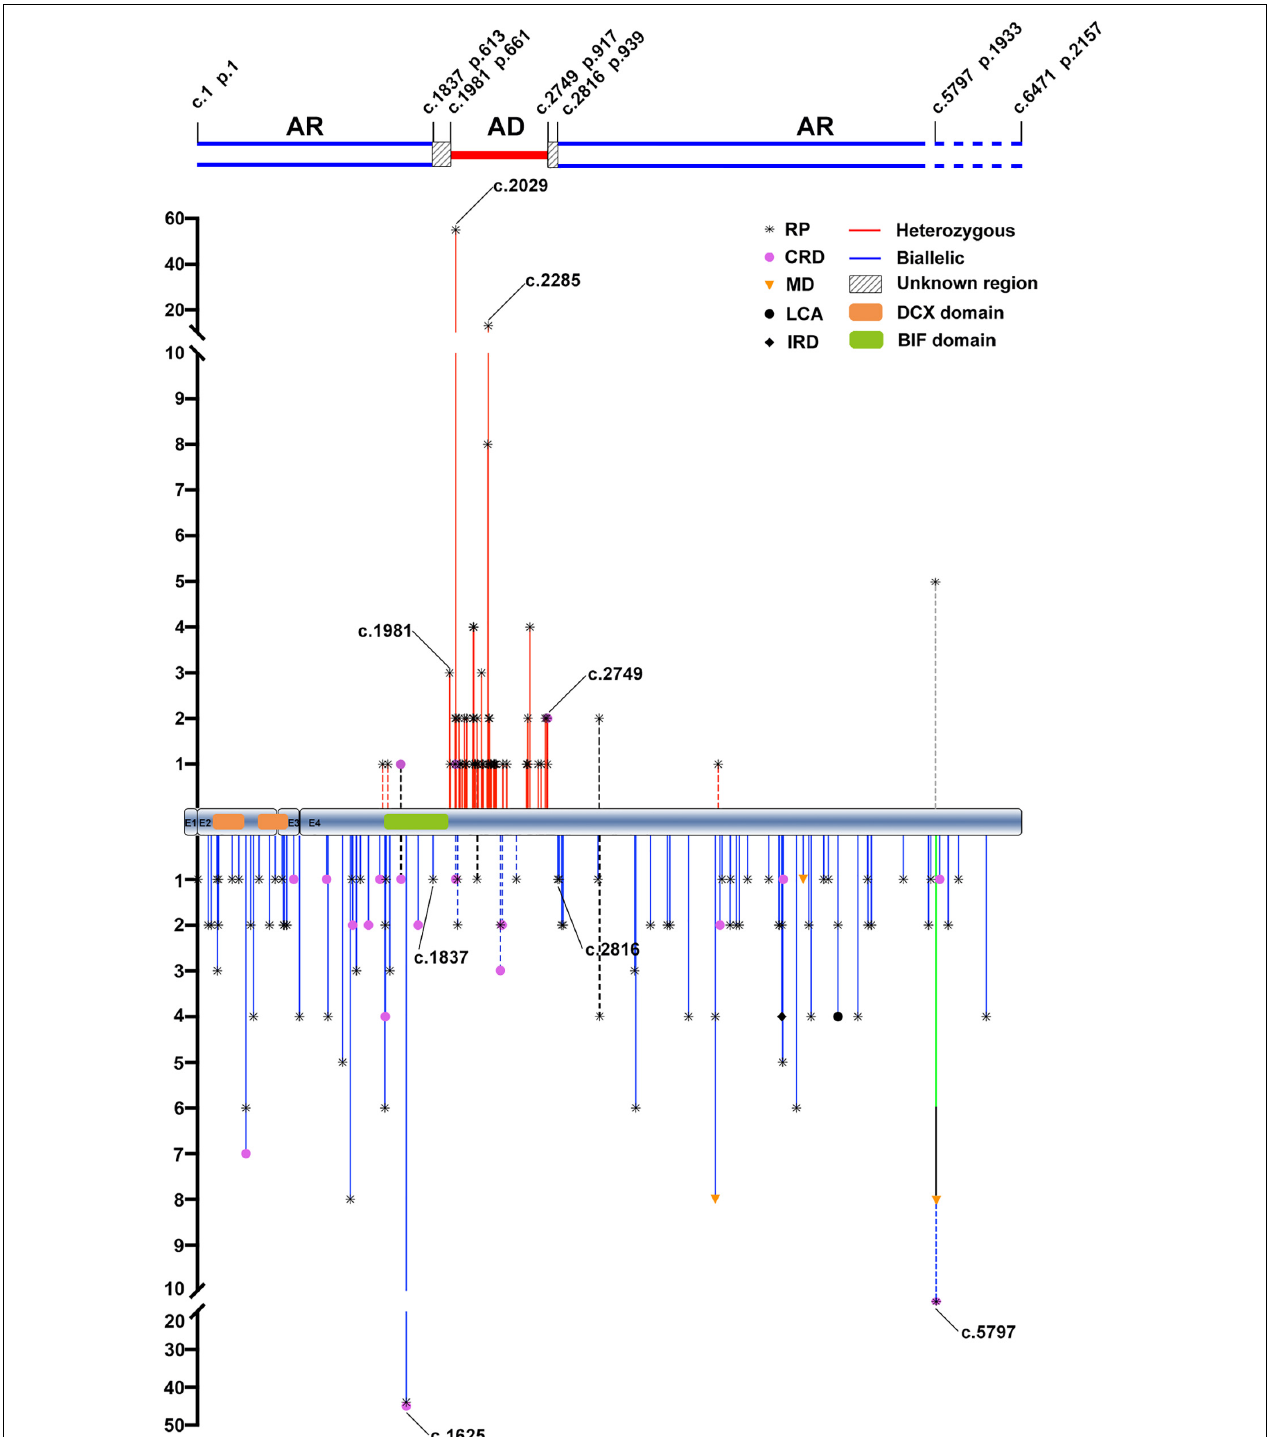
FIGURE 1 | The distribution and frequency of the potential pathogenic truncation variants in RP1 identified in the present and previous studies. AR, autosomal recessive; AD, autosomal dominant; RP, retinitis pigmentosa; CRD, cone-rod dystrophy; MD, macular degeneration; LCA, Leber congenital amaurosis; IRD, inherited retinal disease. The positions and allele counts of the heterozygous RP1 variants are displayed above, while those of the biallelic RP1 variants are displayed below. The two blue lines above represent the autosomal recessive retinitis pigmentosa (arRP) region, the single red line represents the autosomal dominant retinitis pigmentosa (adRP) region, and the diagonal line between them represents the unknown regions. The two blue dashed lines are used to indicate the pathogenicity of homozygous truncations around the c.5797, and thereafter, need to be further clarified. DCX domain: c.106–354 (p.36–188) and c.460-699 (p.154–233). BIF domain: c.1456–1959